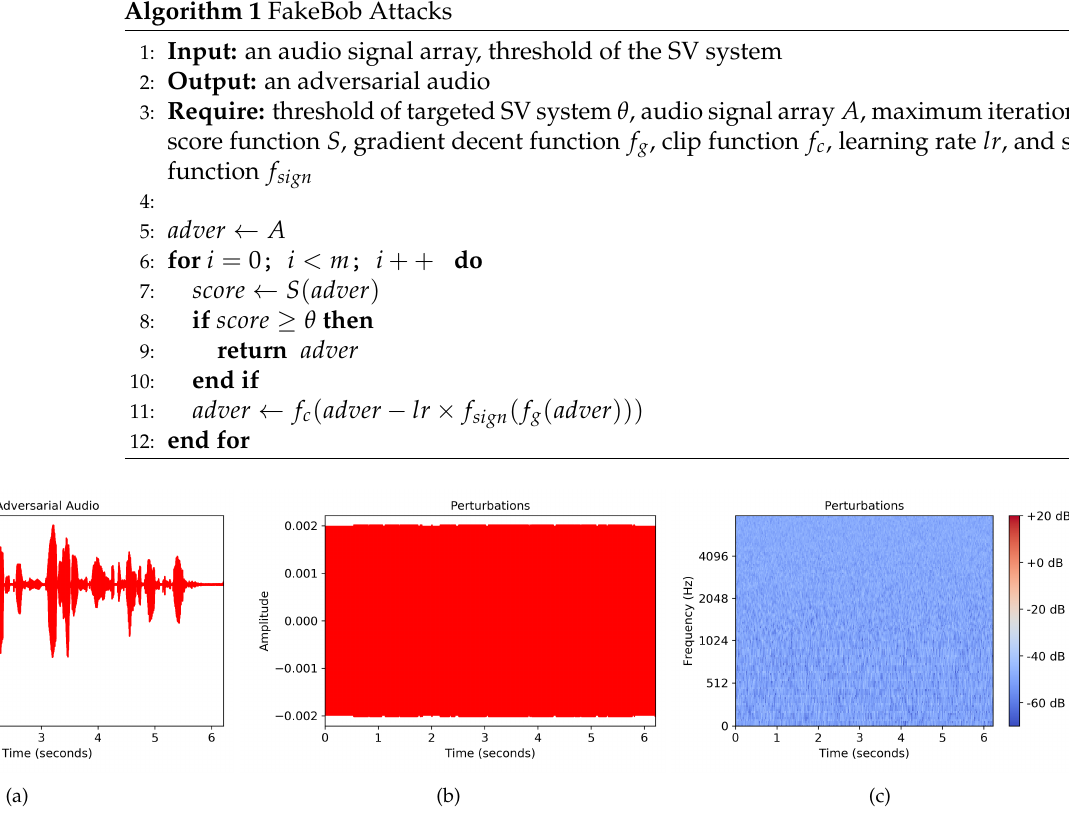
Figure 3. An adversarial audio in the time domain and its perturbations in both the time domain and the mel spectrogram. ( a ) Adversarial audio in time domain; ( b ) perturbations in time domain; ( c ) perturbations in mel